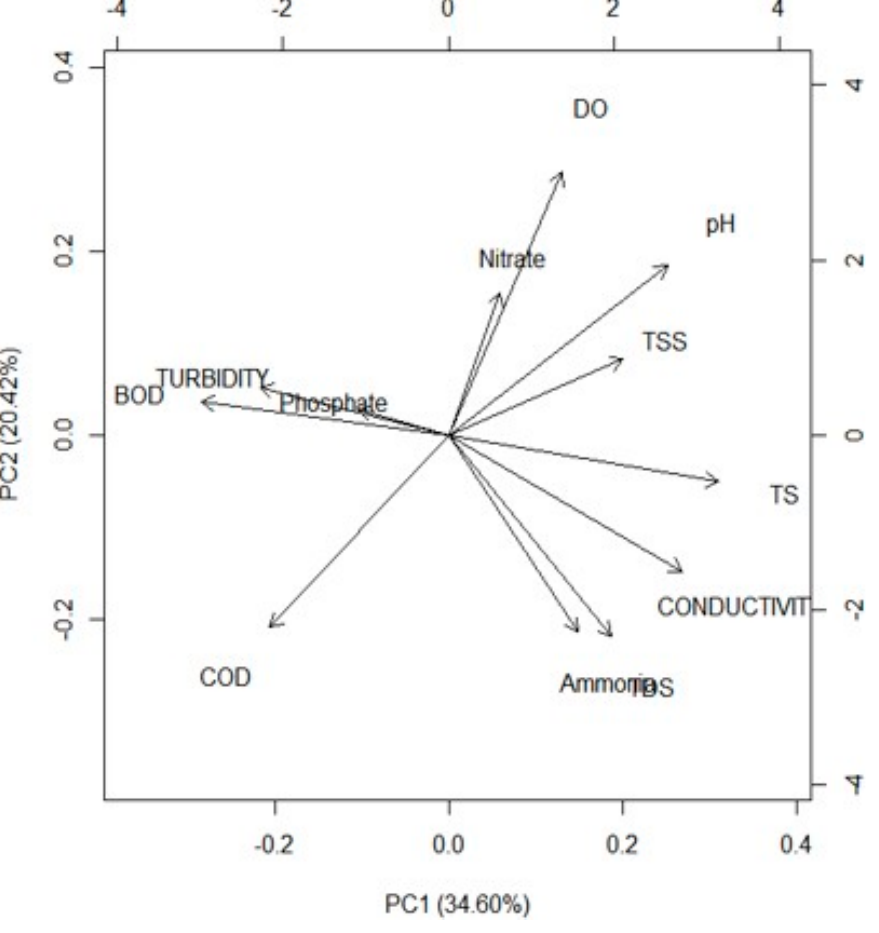
Figure 9. Biplots PC1 vs. PC3.